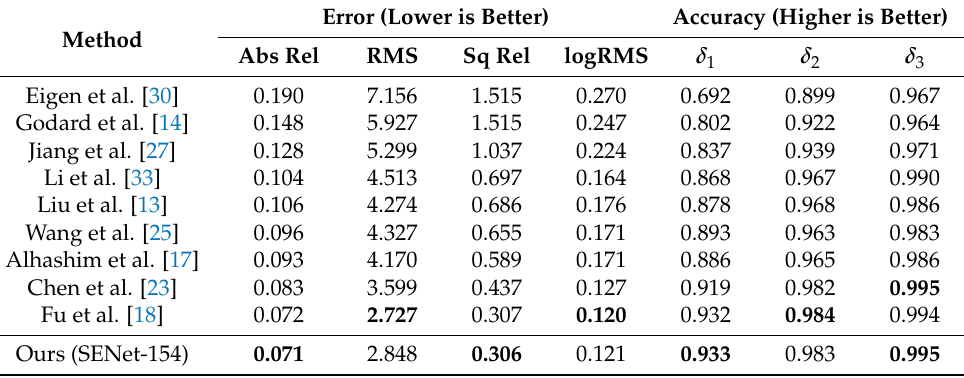
Table 2. Performance evaluation on the KITTI. The best scores are highlighted in bold font. Sq Rel: squared relative